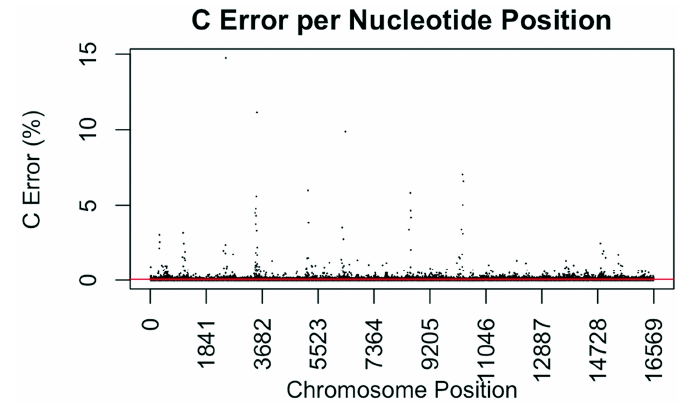
Figure 1. Substitution error rate for A (adenosine) nucleotides per nucleotide position across the mtgenome. The error rate was calculated by dividing the sum of all A calls assumed in error in all samples (all A calls observed at <50%) by the total number of calls (or reads) at that nucleotide position for all samples. The red line indicates the average A error (0.0343%) for all nucleotide positions.